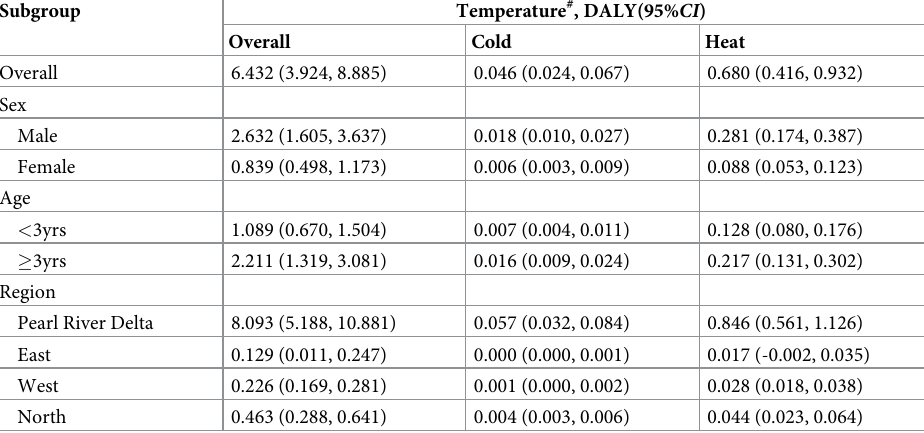
Table 4. Attribute DALYs of HFMD due to temperature in Guangdong,